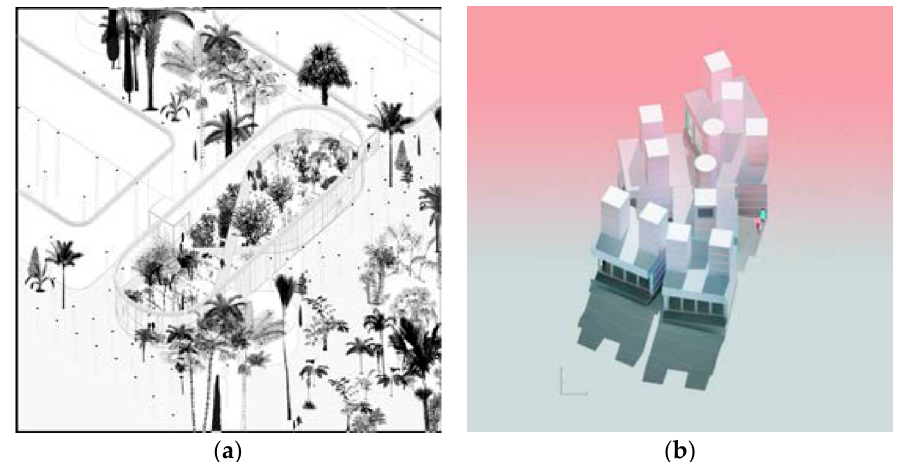
Figure 10. ( a ) LCLA Office, Tropicarium Bogota, 2014; ( b ) MOS Architects, House No. 9,